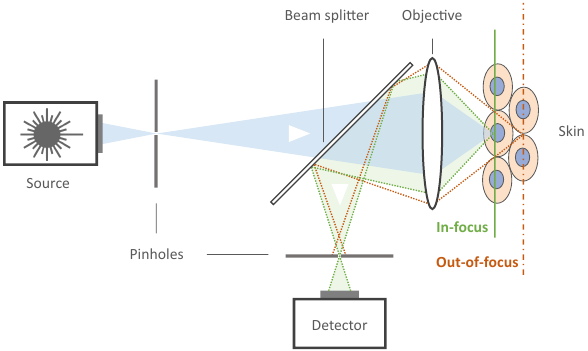
Figure 1. Principle of the RCM designed by Marvin Minsky [9]. The light source is transmitted through a pinhole and focused on the sample through an objective. Then the in-focus reflected light is collected by the detector with the help of the second